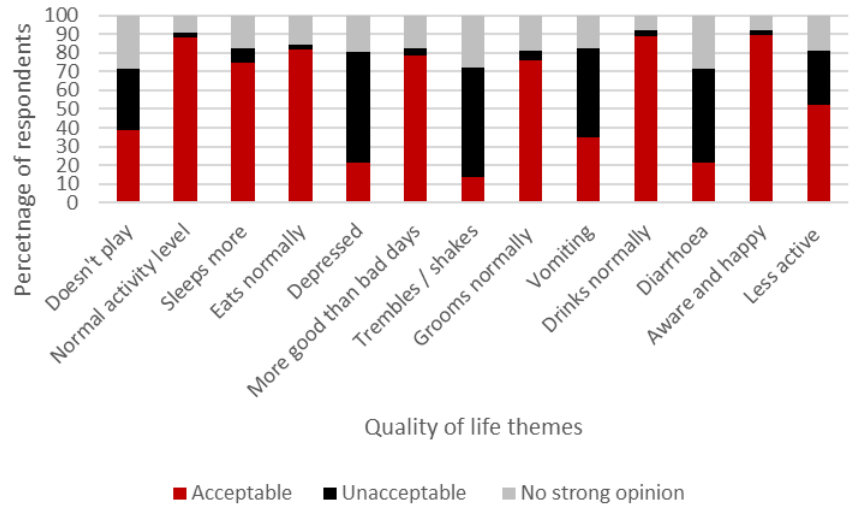
Figure 5. Dog and cat owners’ expectations of pets’ quality of life during and after chemotherapy.